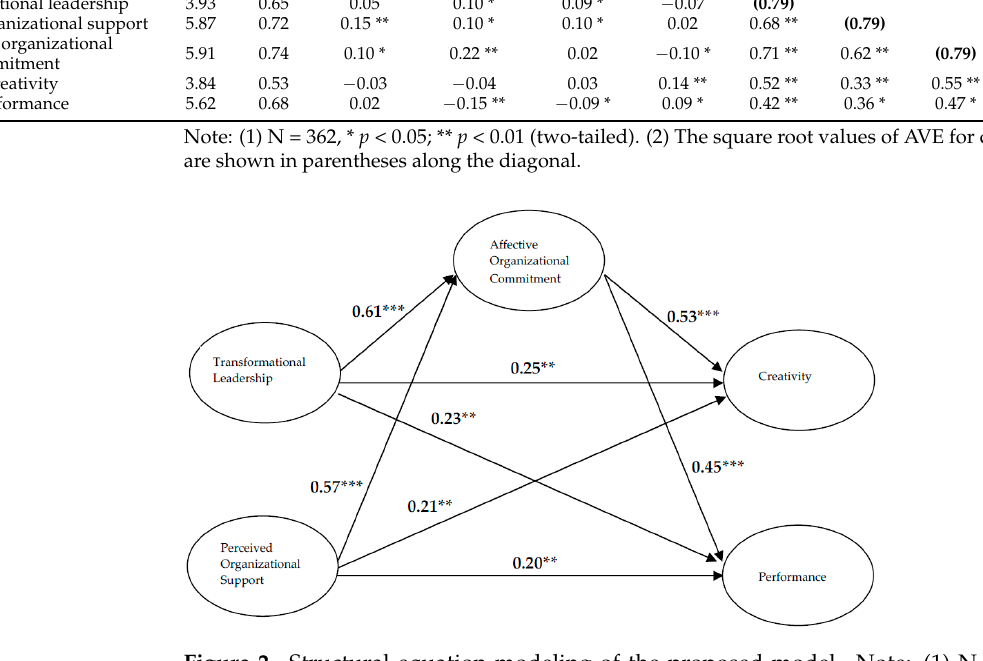
Figure 2. Structural equation modeling of the proposed model. Note: (1) N = 362, ** p < 0.01; *** p < 0.001 (two-tailed). (2) χ 2 = 2111.72, df = 806, χ 2 /df = 2.62, GFI = 0.95, AGFI = 0.95, NFI = 0.95, IFI = 0.95, CFI = 0.95, SRMR = 0.03, and RMSEA =